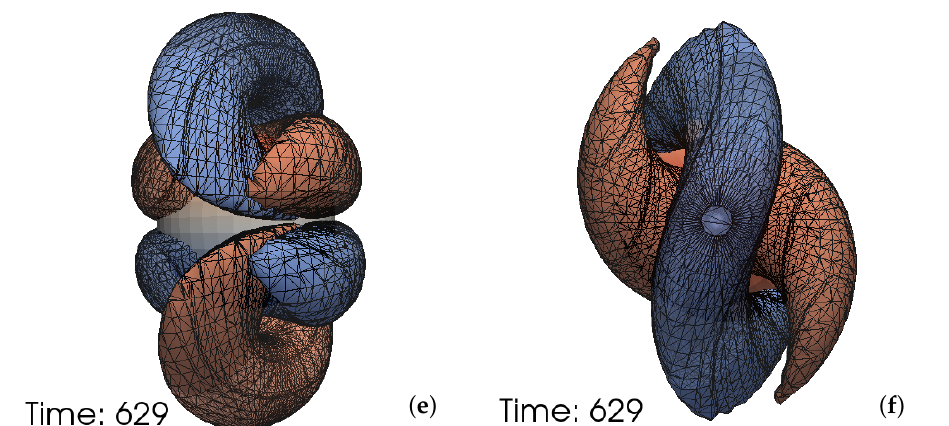
Figure 3. The numerically simulated contours of opposite vorticity in the simulations. ( a – d ): The time evolution of the Coulomb branch vorticity during the merger phase for the SK simulation. The blue and red surfaces are contours of the same absolute vorticity value but of the opposite signs. The rows correspond to di ff erent times. Over time, the red and blue contours become more aligned with each other in their orientation. ( e , f ): The Coulomb branch vorticity contours for the AA simulation, at the same time delay from merger as ( a , b ). The lack of current quadrupole moment ensures the alignment of the red and blue contours. Left column: Side views of the contours (not at the same angle). Right column: Top views (looking down J tot ) of the contours. The grey surface visible in some panels is the apparent horizon of the merged black hole. For merger times, see the right-most time readings in e.g., Figure 6